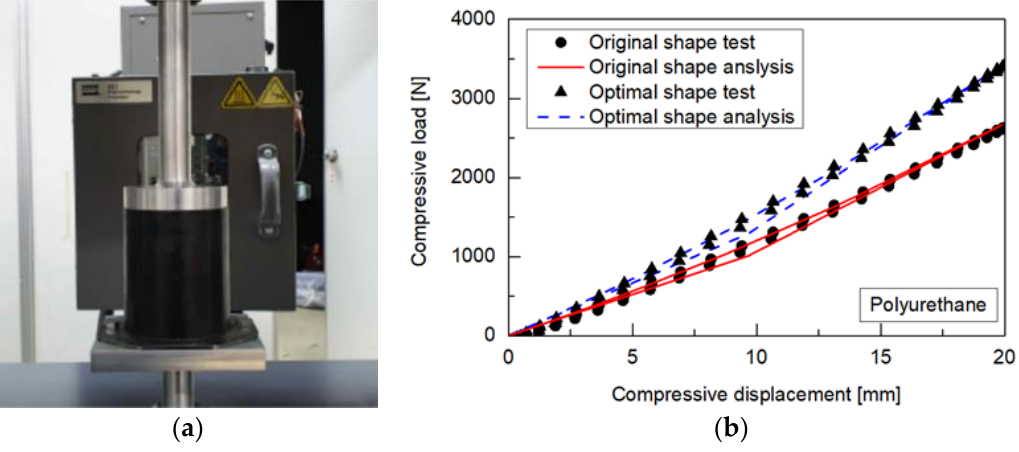
Figure 17. Compressive load-displacement test: ( a ) test rig of polyurethane spring; ( b ) comparison of compressive load displacement between analysis and test.